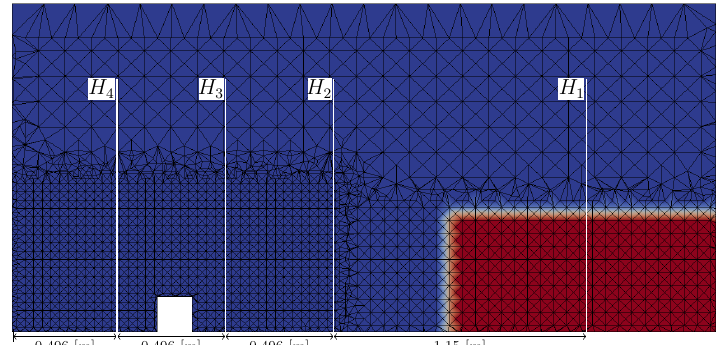
Figure 22. Slice of the mesh at y = 0.5 m and locations of the four measuring points.